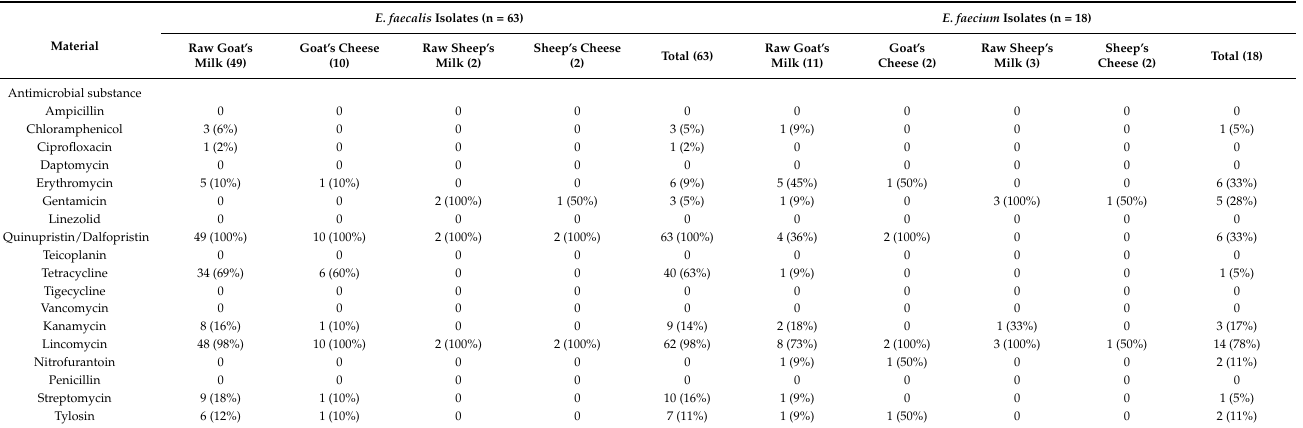
Table 2. Number (%) of antibiotic-resistant Enterococcus faecium and Enterococcus faecalis strains isolated from goat- and sheep-origin dairy product